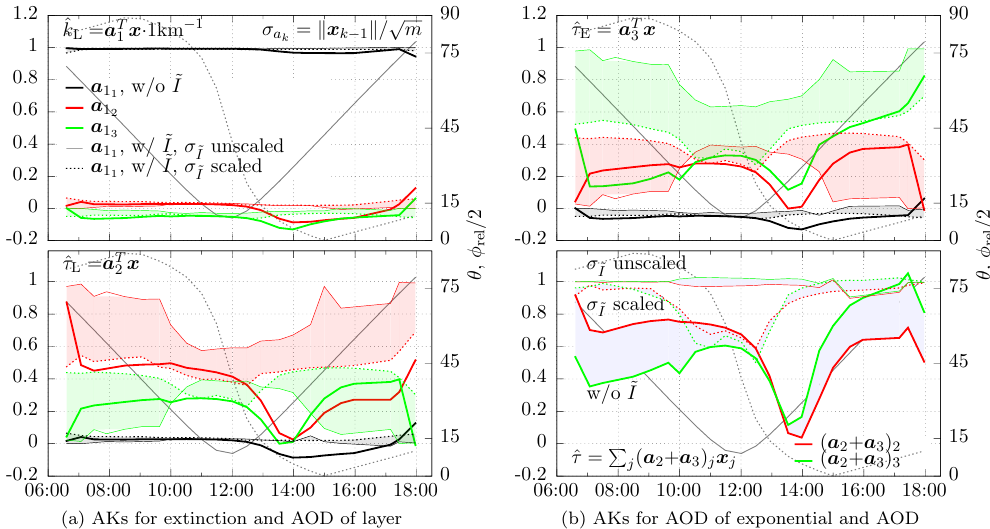
Fig. 13. As Fig. 9, but here for the ground layer profile with τ ∼ 1.2 and choice of the regularisation parameter as in eq.(19). Shown are the cases without ˜ I (bold lines), with ˜ I and fixed σ ˜